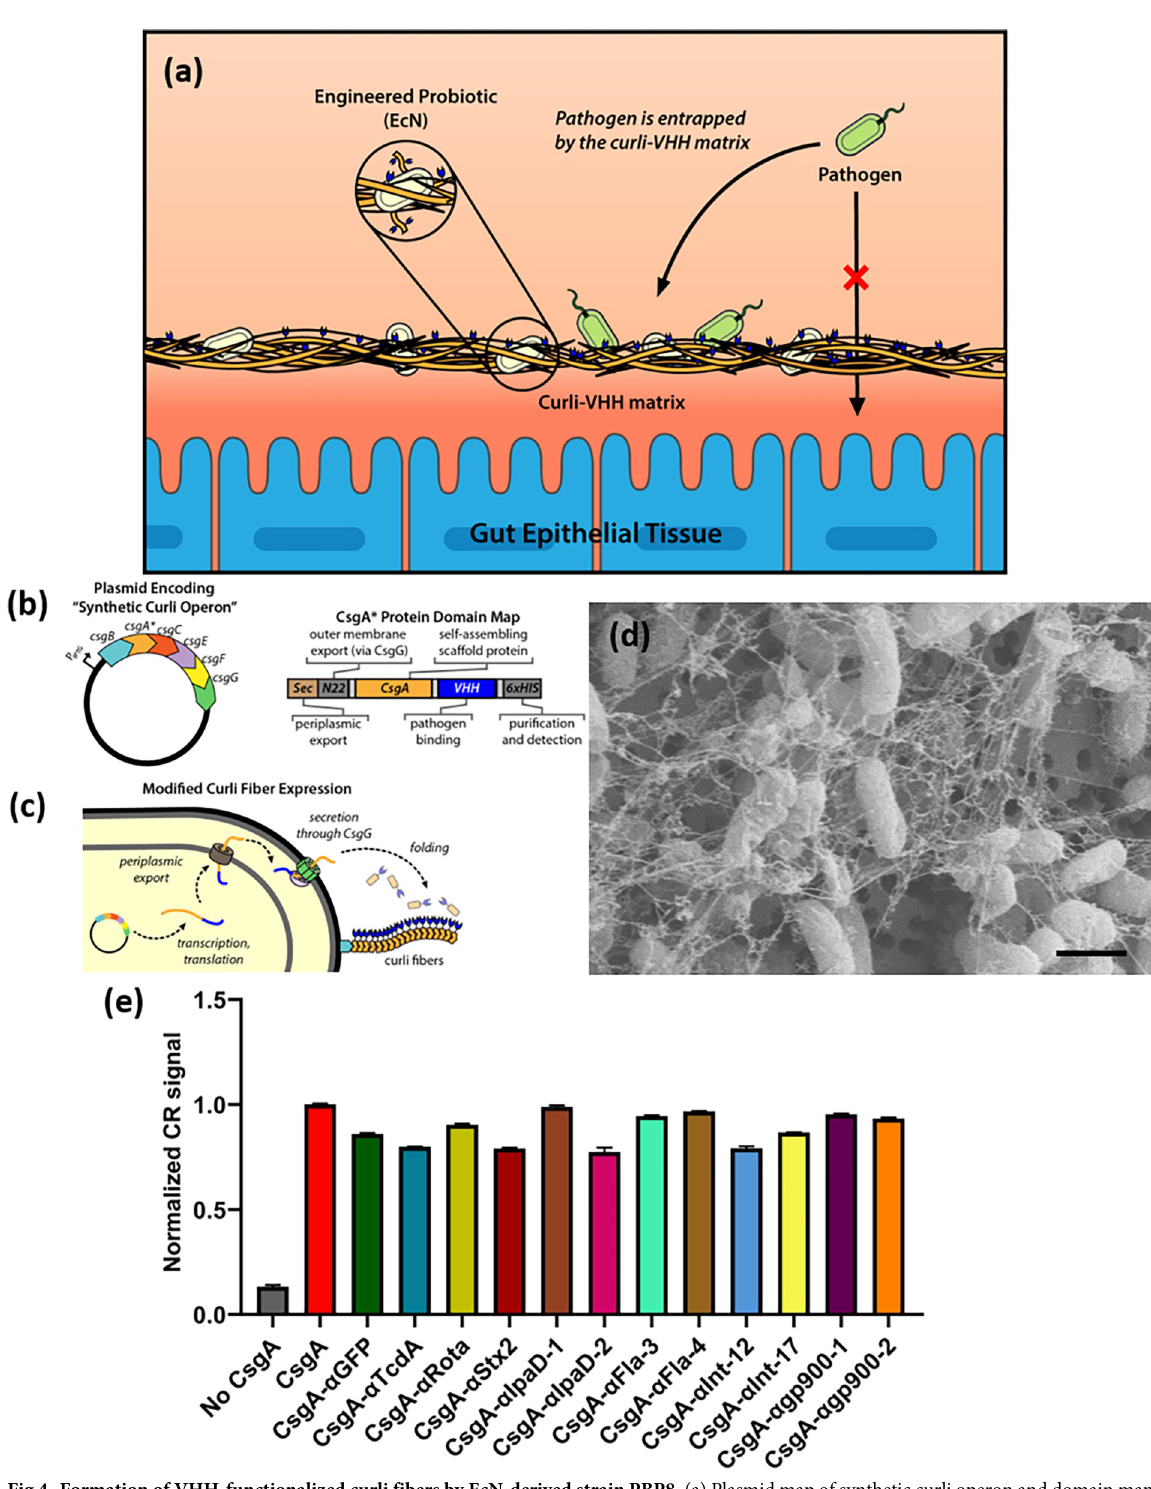
Fig 4. Formation of VHH-functionalized curli fibers by EcN-derived strain PBP8. (a) Plasmid map of synthetic curli operon and domain map of CsgA-VHH fusion constructs. (b) Idealized schematic of curli fiber export and self-assembly mechanism. (c) Representative scanning electron micrograph demonstrating the formation of curli fibers by CsgA-VHH-expressing PBP8 (CsgA- α gp900-2, scale bar = 1 μ m). (d) Congo Red (CR) binding assays of induced cultures of PBP8 bearing plasmids encoding various CsgA-VHH constructs. CR binding is indicative of the formation of curli protein fibers. Data corresponds to A 490 measurements normalized to the CsgA positive control, and is presented as